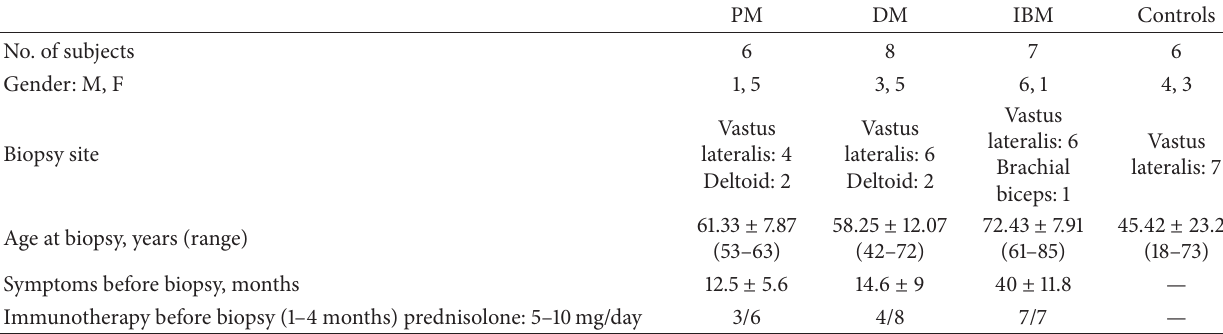
Table 1: Demographic